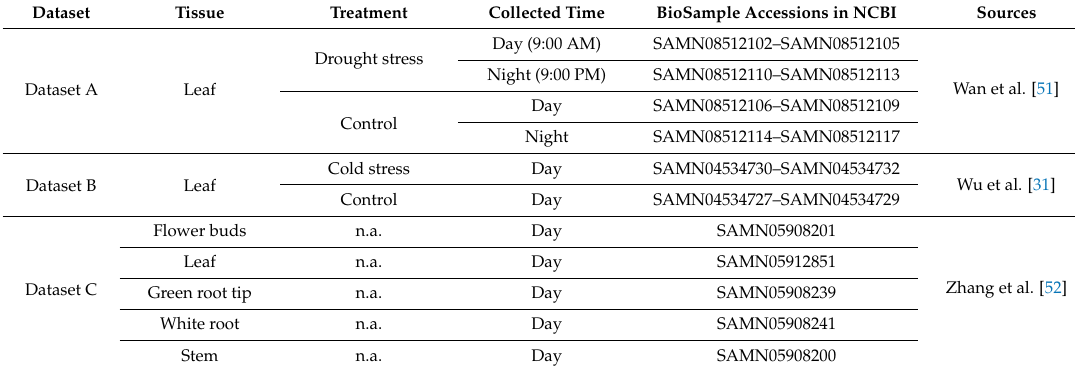
Table 2. Treatments and accessions of biosamples in this